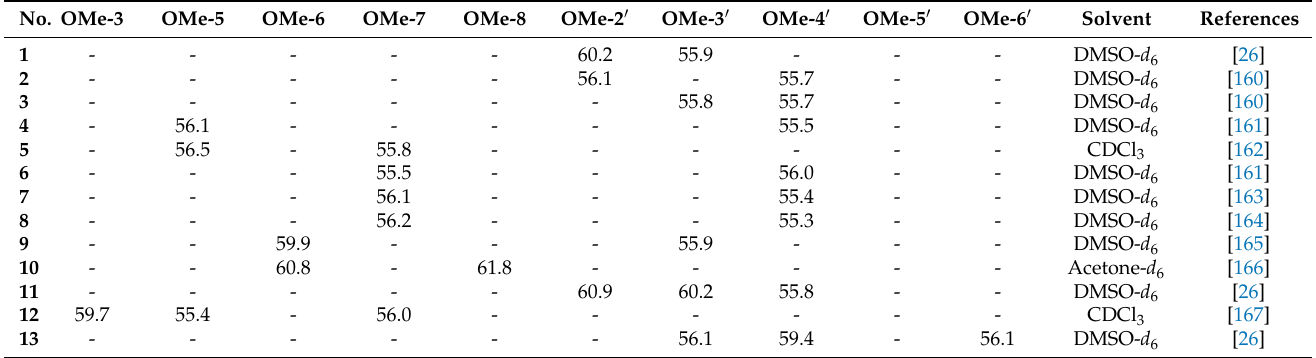
Table 11. 13 C-NMR of polymethoxyflavones’ ( 1 – 71 ) methoxy groups occurring in Citrus